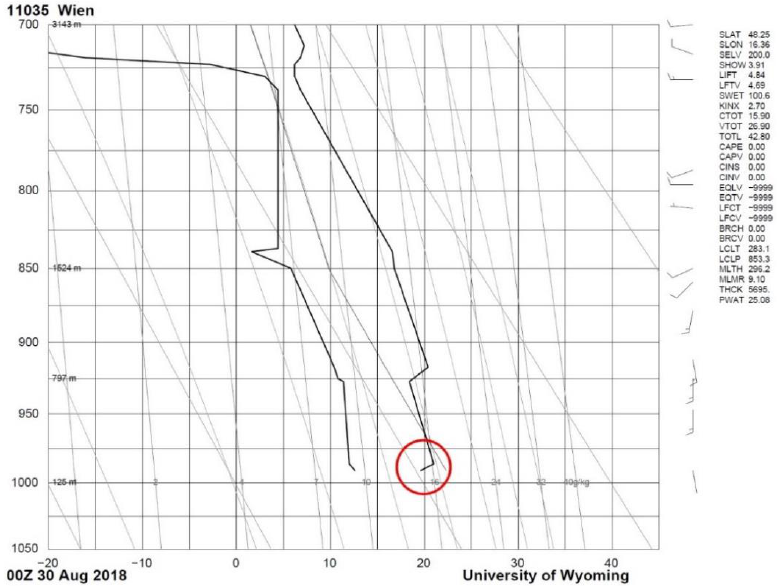
Figure 6. Outcome of the air sounding at midnight on 30 August 2018 at the meteorological station 11035 in Vienna, Austria. The two thick black lines indicate the dry-bulb (right) and the wet-bulb (left) air temperature. The inversion is indicated by the red circle. Source: http://weather.uwyo.edu/upperair/sounding.html.